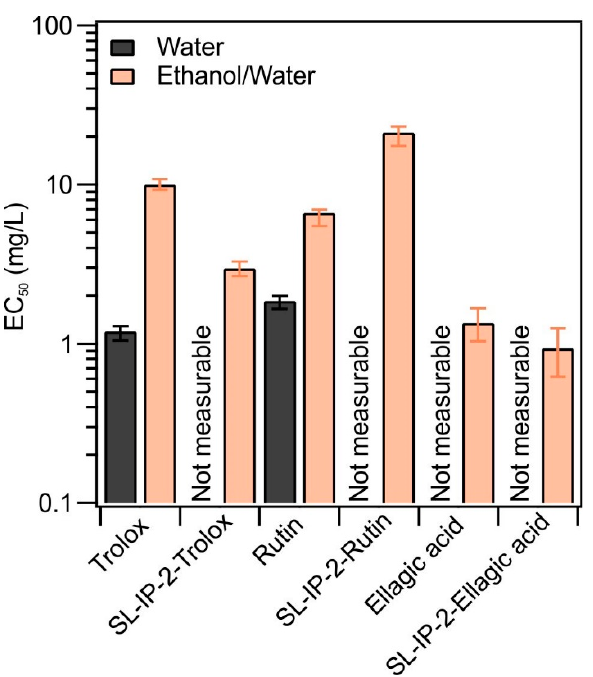
Figure 5. Effective concentrations measured in homogeneous solutions of the antioxidants and in the presence of SL ‐ IP ‐ 2 in different solvents (water (dark bars) and ethanol/water (light